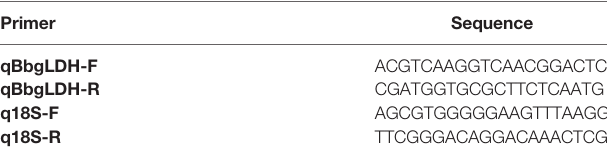
TABLE 1 | qPCR primers used in this